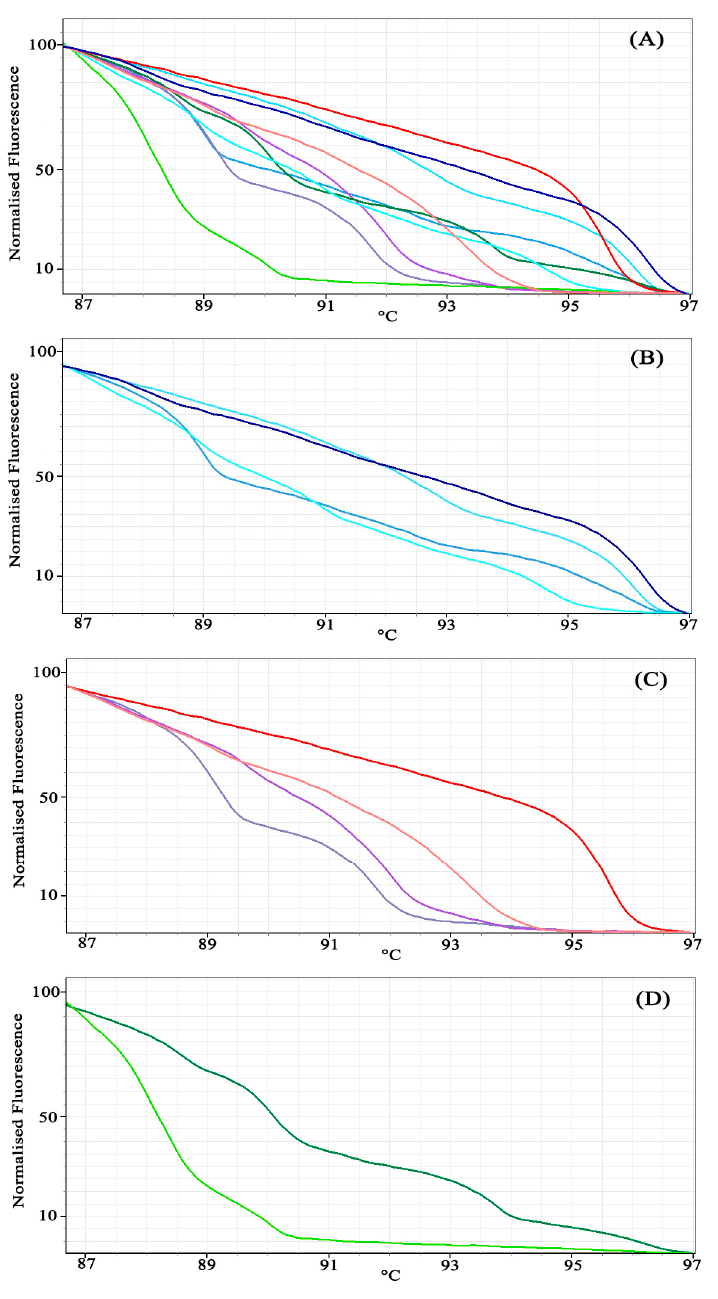
Figure 4. Melting profiles of ten Dipterocarpaceae species generated from HRM analysis using ITS1 primers. Normalised curves of ( A ) all 10 species; ( B ) species from genus Dipterocarpus ; ( C ) species from genus Shorea ; ( D ) species from genus Hopea .